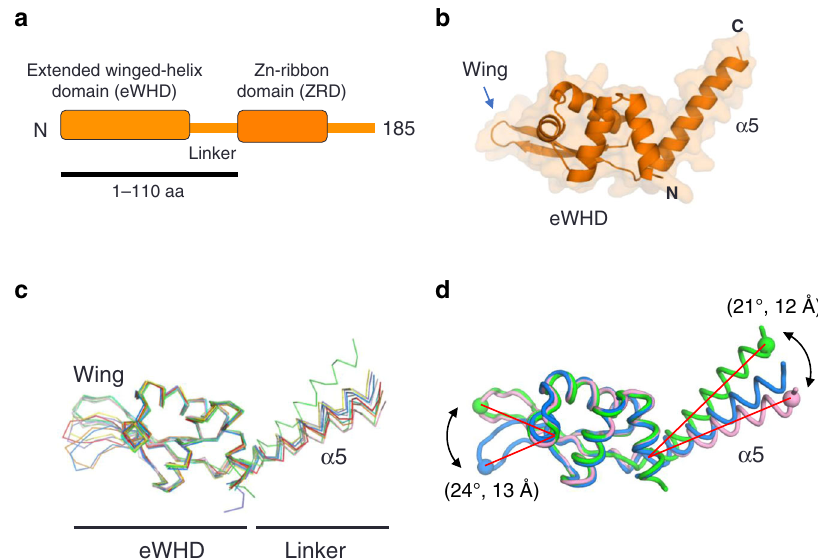
Fig. 1 X-ray crystal structure of Pfu TFE αΔ ZRD. a Domain organization of the TFE α . The amino acid region used for crystallization is underlined. b A ribbon model of TFE αΔ ZRD is shown with transparent surface. c Ten crystallographically independent TFE αΔ ZRD structures are shown as α -carbon backbone. The structures are superimposed via eWHD with wing excepted, showing fl exibility in the orientations of the wing and linker. d Flexibilities of the wing and linker of TFE α . Three representative conformations of crystallographically independent TFE αΔ ZRD show swing motions of the wing and linker of TFE α .